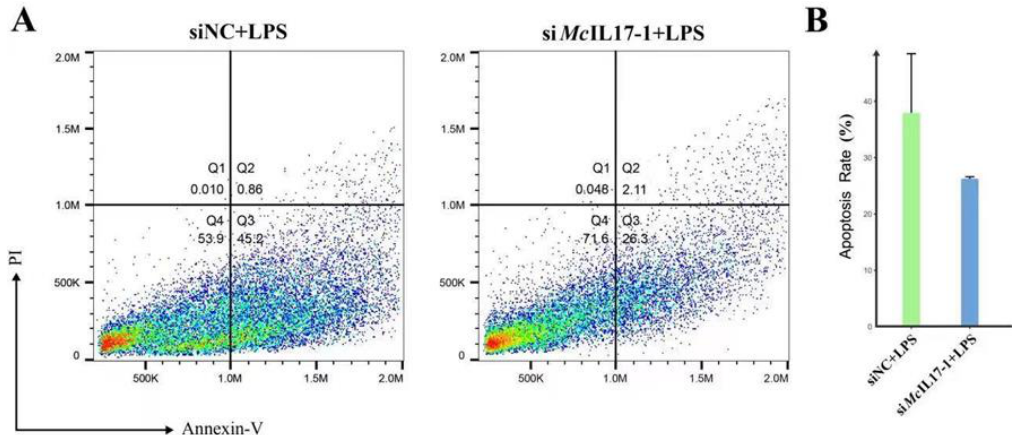
Figure 6. Apoptotic rate in hemocytes of M. coruscus after LPS treatment and after Mc IL17-1 was knocked-down. The apoptotic rate of hemocytes was detected by flow cytometry with Annexin V-FITC and propidium iodide (PI) staining. ( A ) Apoptotic rate in RNAi mussel hemocytes. siNC + LPS: The apoptosis rate of hemocytes at 24 h after LPS challenge in siNC group; si Mc IL17-1 +LPS: The apoptosis rate of hemocytes at 24 h after LPS challenge in si Mc IL17-1 group. Quadrant: Q4: live cells; Q3: early apoptotic cells; Q2: late apoptotic cells; Q1: necrotic cells. ( B ) The changes of the apoptotic rate of hemocytes after dsRNA